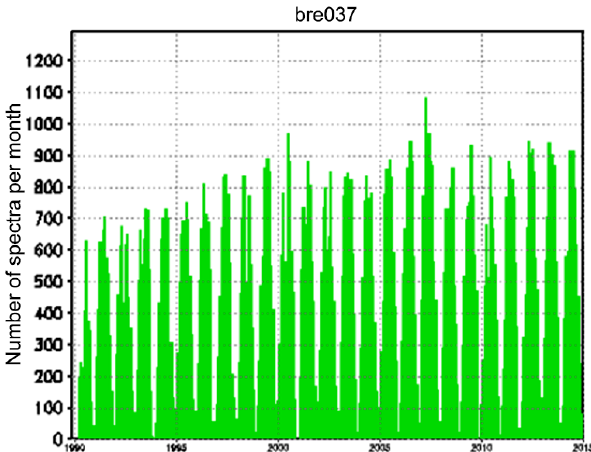
Figure 2. Graphical summary on the spectral UV irradiance data measured by Brewer #037 in Sodankylä in 1990–2014: monthly number of spectra as a screenshot of the on-the-screen display by the www-based interface to the